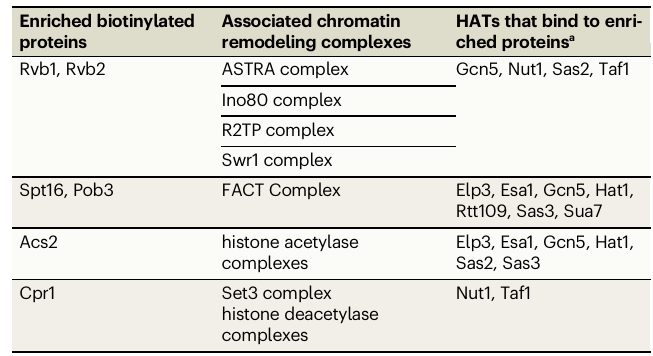
Table 1 | Enriched biotinylated proteins associated with chromatin remodeling and Histone Acetyltransferase (HAT) complexes Enriched biotinylated